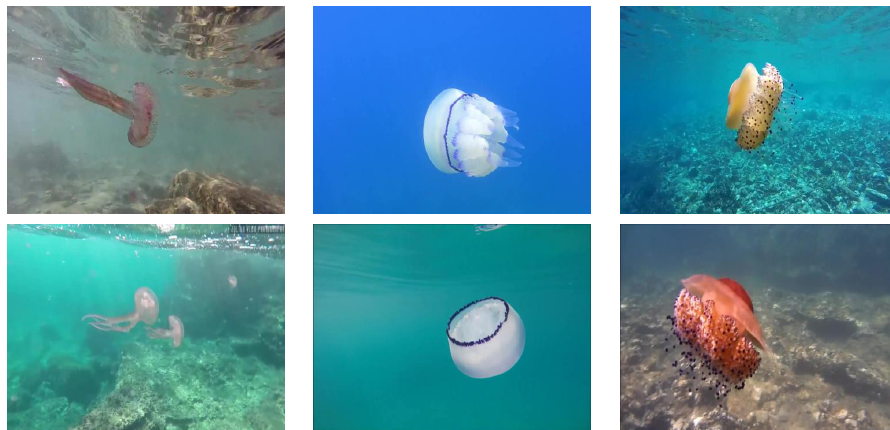
Figure 3. Images from the dataset showing the three jellyfish species under different environmental conditions. Left : P. noctiluca , center : R. pulmo , right : C. tuberculata .